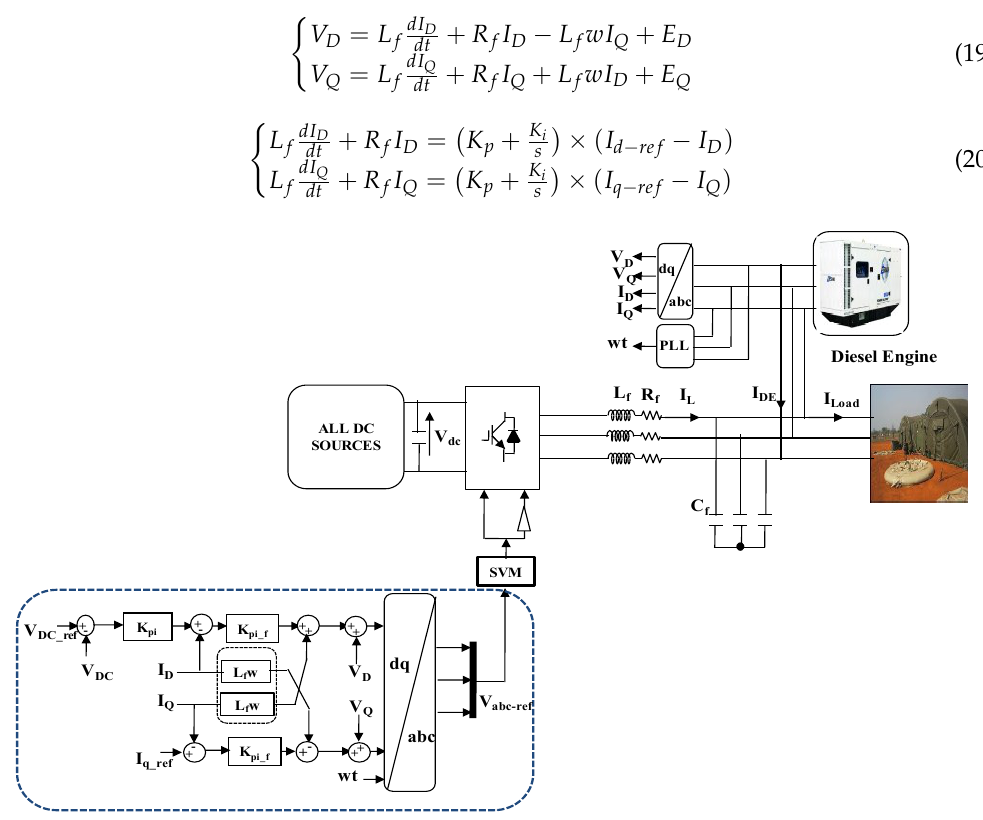
Figure 12. Functional diagram of voltage-oriented control